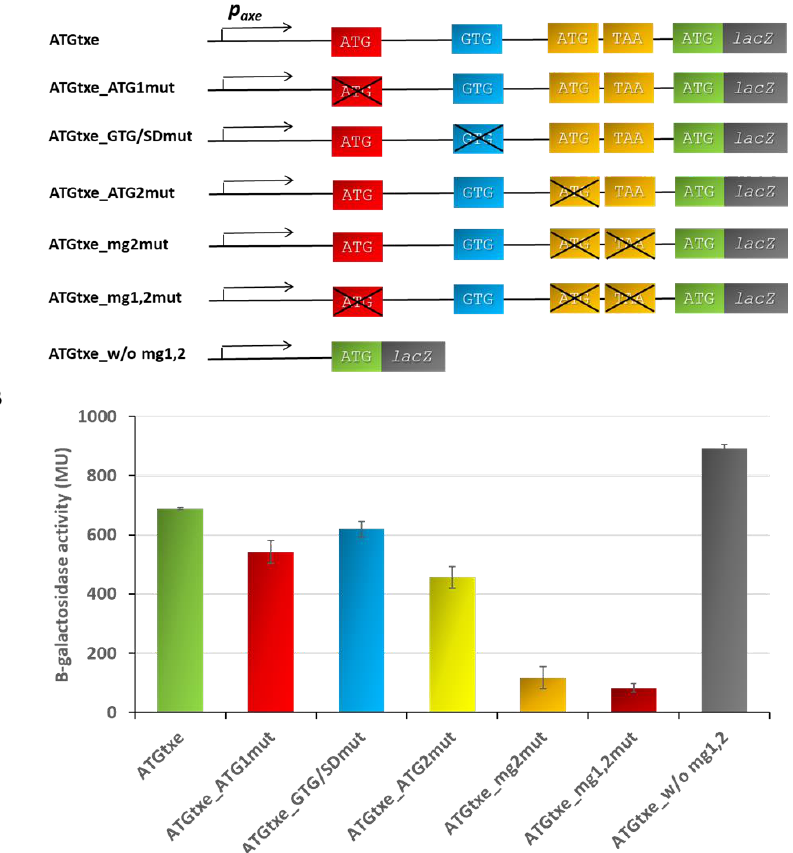
Figure 3. Mutational analysis of the p axe leader. ( A ) Schematic representation of pRW225_ATGtxe and its derivatives carrying inactivated start and/or stop codons, indicated by black cross. ( B ) β - galactosidase activities were assessed in the E. coli ∆ 5 ∆ lac strain carrying derivatives of pRW225 vector, as indicated. Reporter activity was measured when cell cultures reached OD 600 ≈ 0.5. These results are the average of at least three independent experiments; error bars represent standard deviation (S.D.). The p -values calculated for ATGtxe versus all other constructs showed statistical significance ( p < 0.05). In addition, the difference between ATGtxe_mg2mut versus ATGtxe_mg1,2mut is statistically significant.